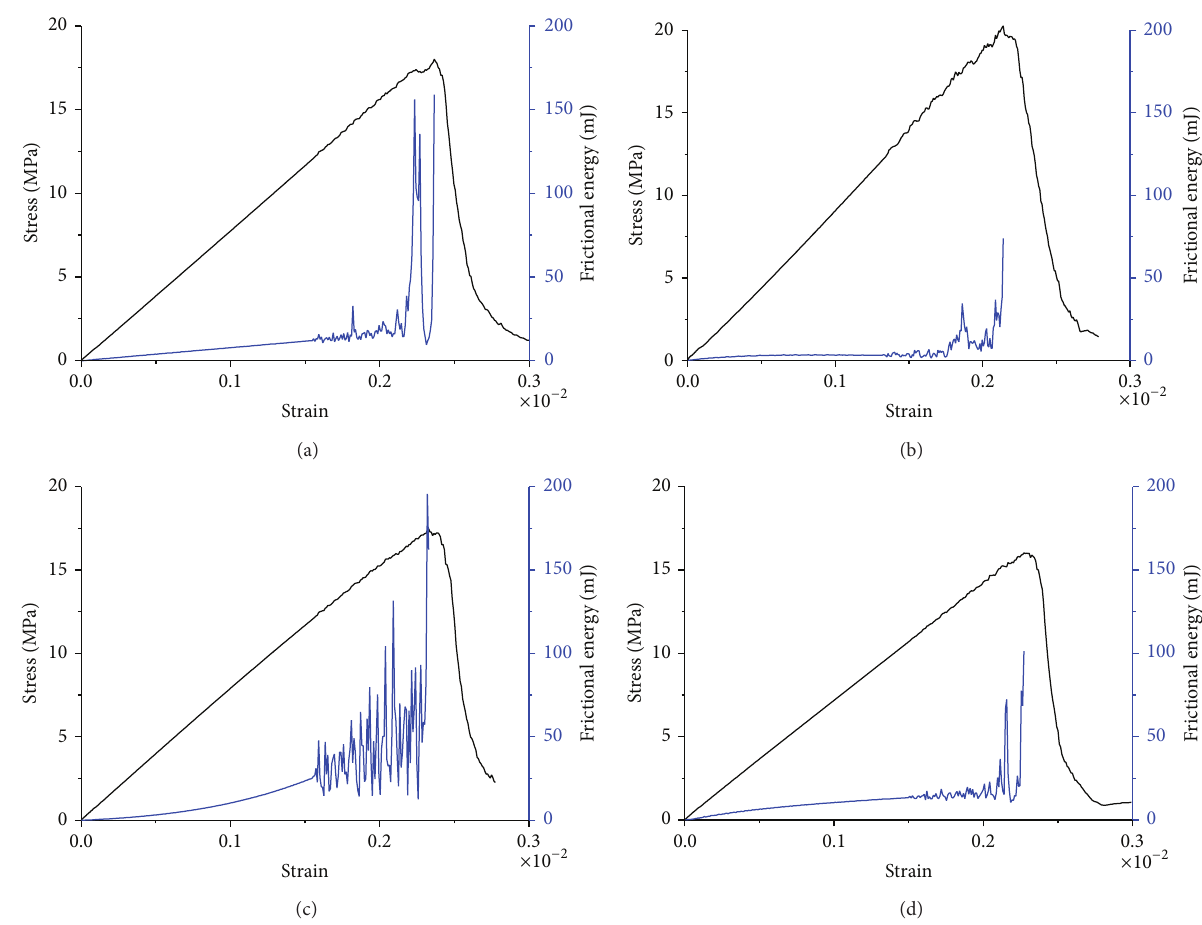
Figure 4: Frictional energy and stress curves of different methods. (a) Method 1; (b) method 2; (c) method 3; and (d) method 4.